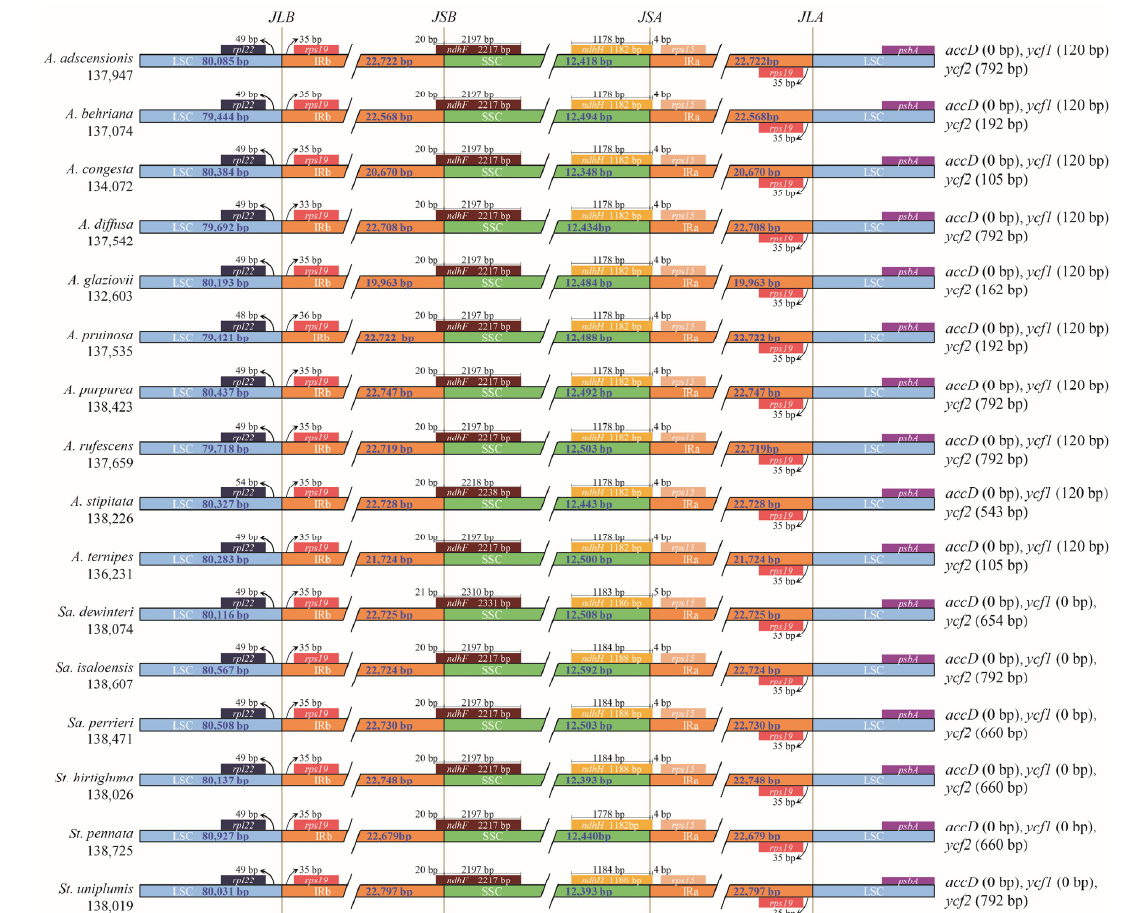
Figure 4. Comparison of boundaries of LSC, SSC, and IRs among 16 species in Aristidoideae. JLB: LSC/IRb junctions; JSB: SSC/ IRb junctions; JSA: SSC/ IRa junctions; JLA: LSC/IRa junctions. The gene names behind each species represents the lost genes in this species, and the number in parentheses represents the length of the residual gene fragment.